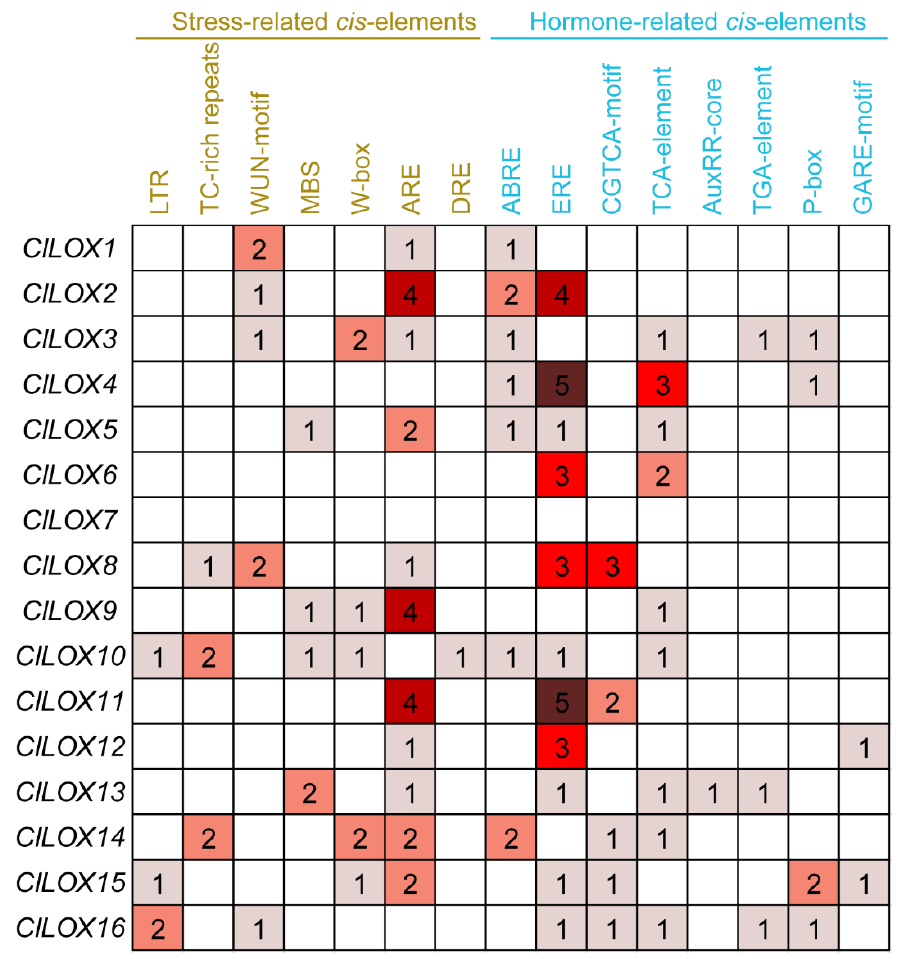
Figure 5. Analysis of stress- and hormone-related cis -elements in the promoter regions ( − 2000 bp) of ClLOX genes. The numbers of cis -elements are boxed.